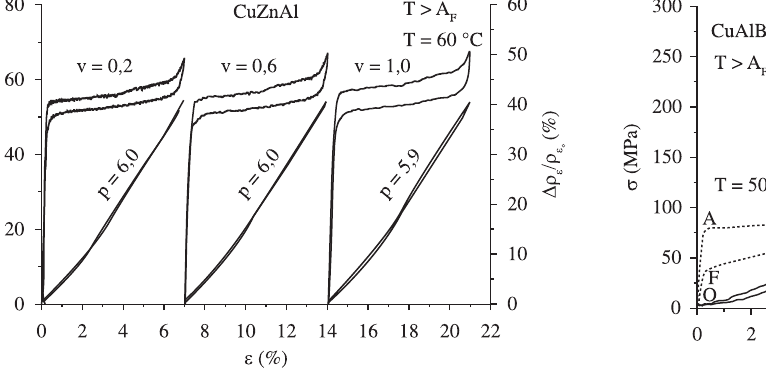
Figure 3. Strain rate influence in the superelastic electro-mechanical curves of CZA11 sample for strain rates: 0.2, 0.6 and 1.0%/mim.